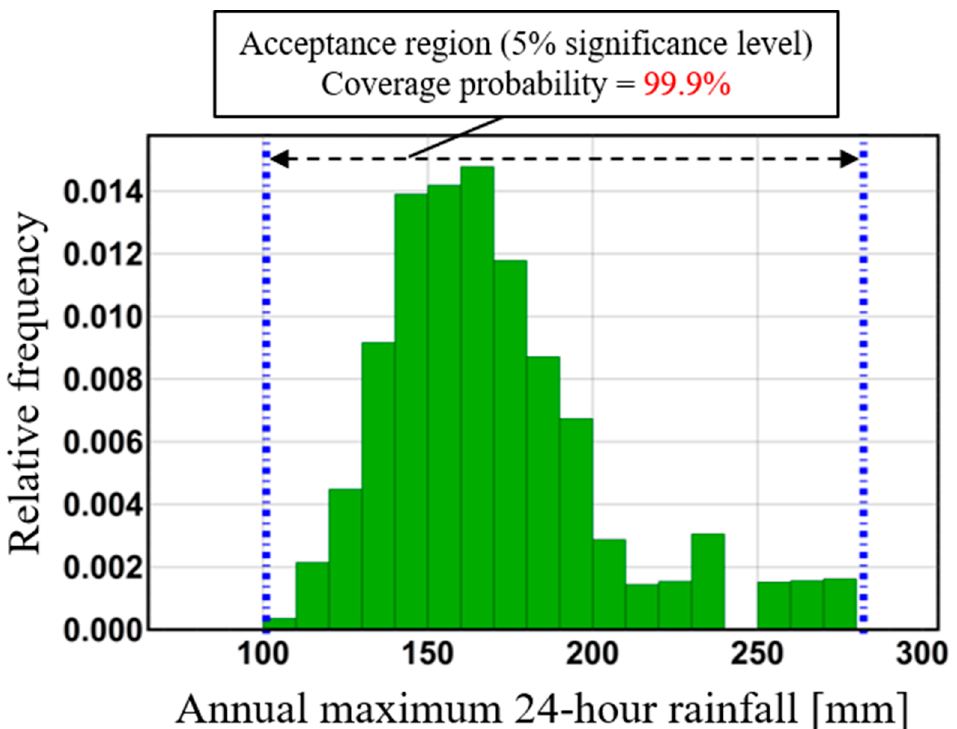
Figure 19. Acceptance region based on probability limit method test with 5% two-sided probability for Gumbel distribution fitted to analytical data vs. a histogram of 49th-order statistics constructed from 5,000 resampled samples from past experiment data.